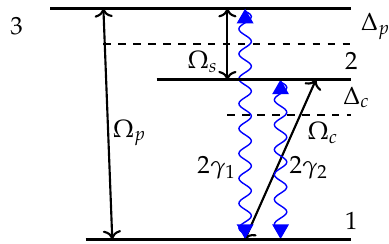
Figure 3. A classical configuration of a V-type three-level atom where Ω s is a shaped microwave